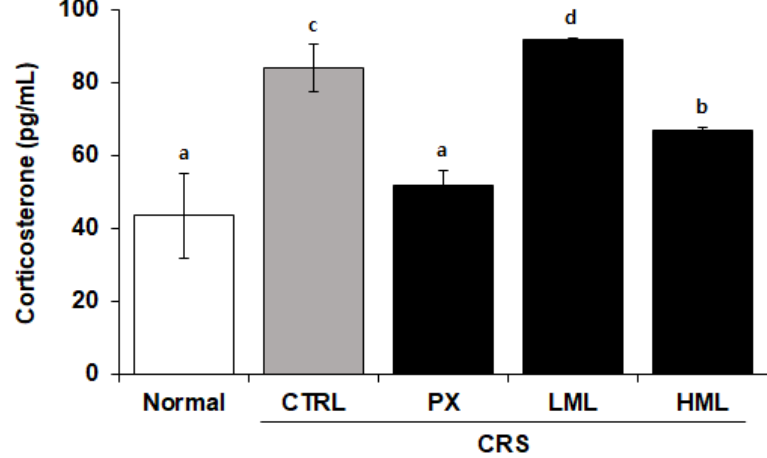
Figure 2. E ff ect of the ML extracts on corticosterone levels in the plasma. Mice were restrained for 2 h per day for 28 consecutive days after the treatments, and the corticosterone levels were measured in the plasma. Data represent means ± SEM ( n = 5). Di ff erent letters (a–d) above the bars indicate significant di ff erences at p < 0.05. CRS—chronic restraint stress; PX—paroxetine; LML—low-concentration mustard leaf; HML—high-concentration mustard leaf.